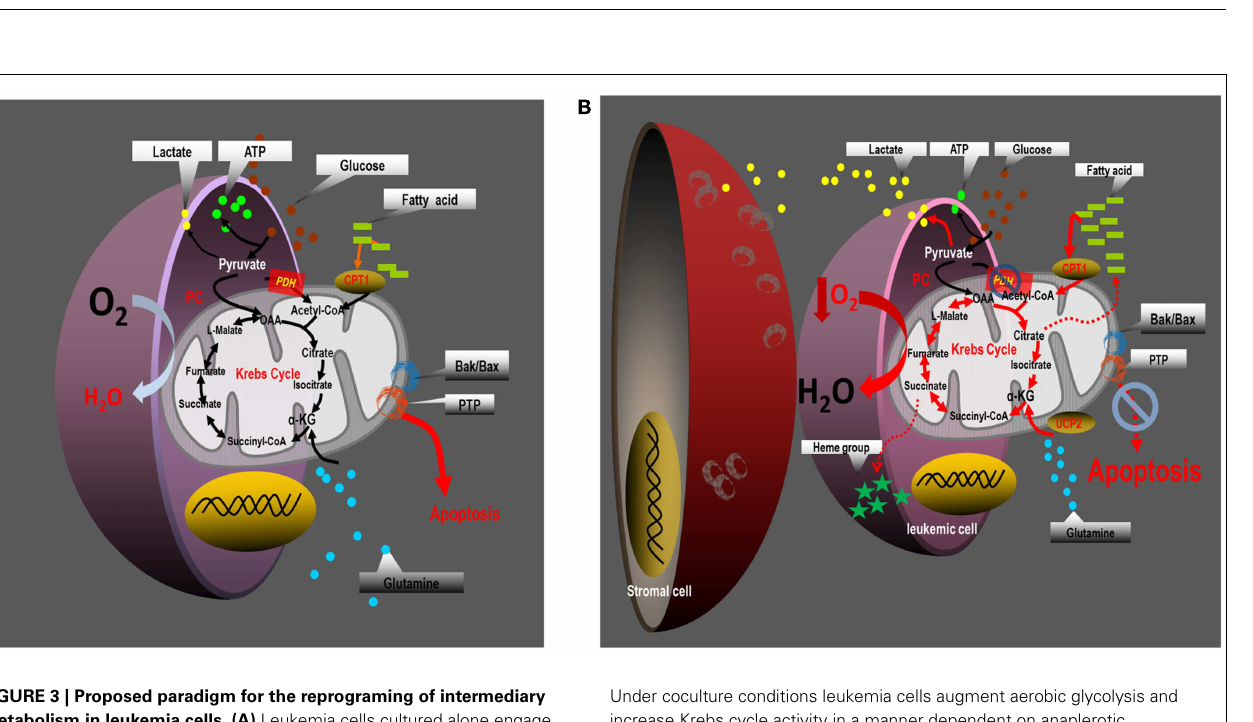
FIGURE 3 | Proposed paradigm for the reprograming of intermediary metabolism in leukemia cells. (A) Leukemia cells cultured alone engage in aerobic glycolysis, and maintain an intact Krebs cycle which is capable of oxidizing pyruvate-derived acetyl-CoA, fatty acid-derived acetyl-CoA, and possibly glutamine carbon skeletons.Their energy demands are met through glycolysis and perhaps to some extent through mitochondrial OXPHOS, although mitochondria may display a proclivity for uncoupling electron transport from ATP synthesis. In monoculture, leukemia cells are most sensitive to apoptosis induction. (B) Coculture of leukemia cells with bone marrow-derived stromal cells promotes mitochondrial uncoupling.